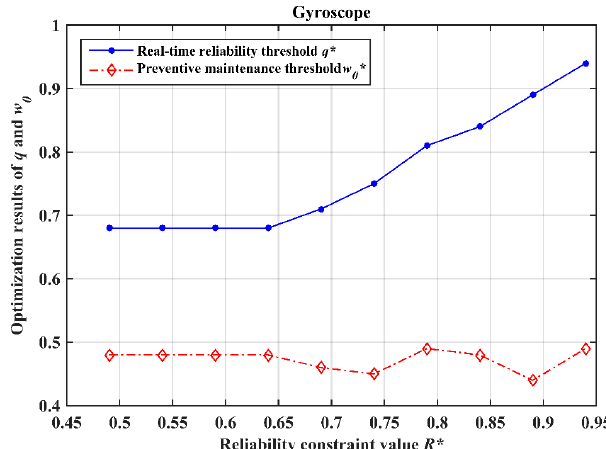
Figure 10. Sensitivity analysis of the effects of the reliability constraint value 𝑅 ∗ on the optimal values 𝑞 ∗ and 𝑤 (cid:2868)∗ .